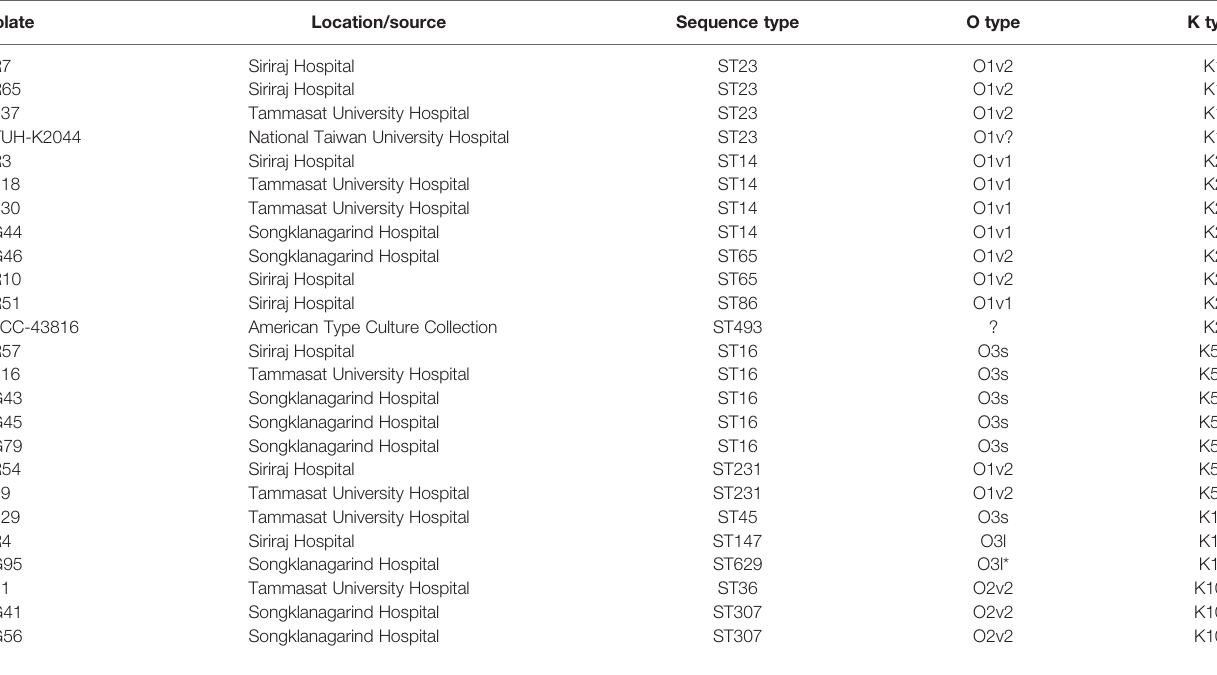
TABLE 1 | K. pneumoniae isolates used in this